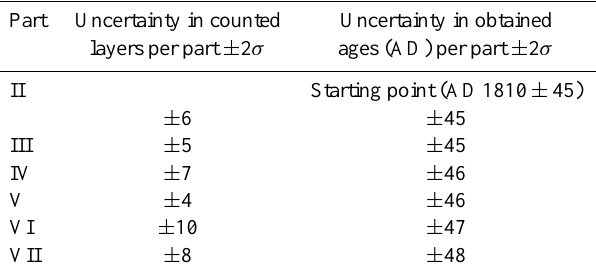
Table 3. Uncertainties in the counted layers per part below the per- turbation (II to VII) together with the uncertainties in the obtained ages (AD) per part using the age of AD1810 ± 45 as the starting point for the age model